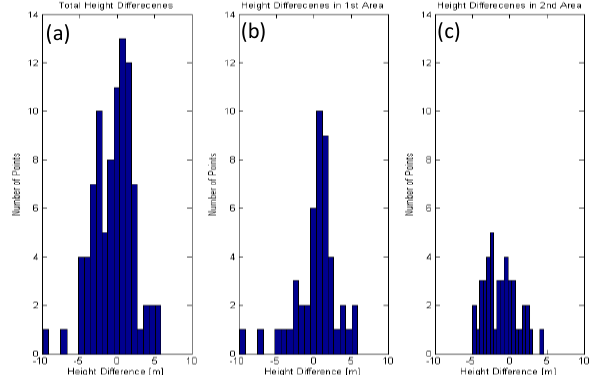
Figure 4. Height differences histograms in Herzliya: a) both areas, b) urban area, c) open area